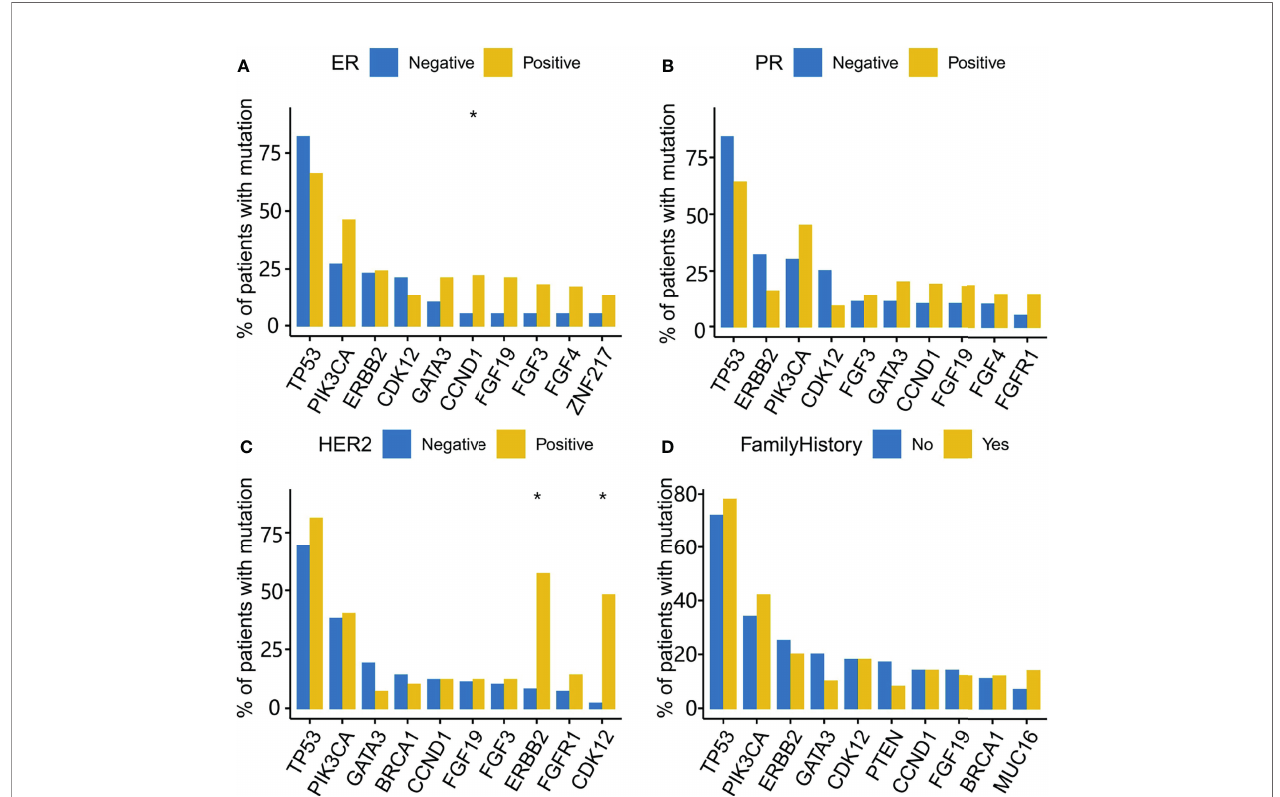
FIGURE 2 | Gene mutations associated with ER, PR, HER2, and a family history of cancer (FH). The top 10 mutated genes are used in the analysis of mutational association with ER (A) , PR (B) , HER2 (C) , and FH (D) . The Y-axis indicates the percentage of patients with the mutated genes across the X-axis for receptor- positive and -negative groups. *, adjusted ( Figure 3 ). From the heatmap result, four clusters having a high associationwithinthemweremarkedwithrectangles.Patientswere classi fi edinto fourcorresponding groups if there isa genemutation